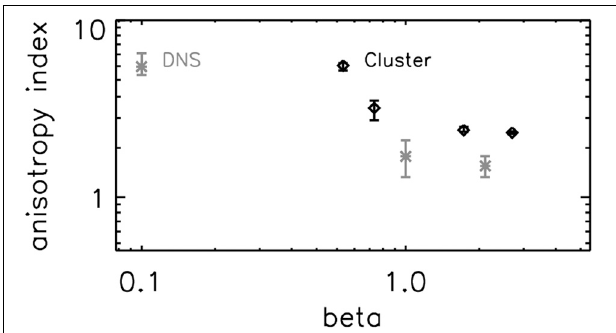
FIGURE 4 | Anisotropy index as a function of the plasma parameter beta.